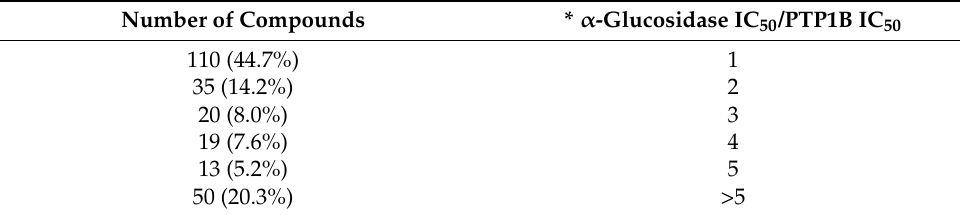
Table 15. Calculated IC 50